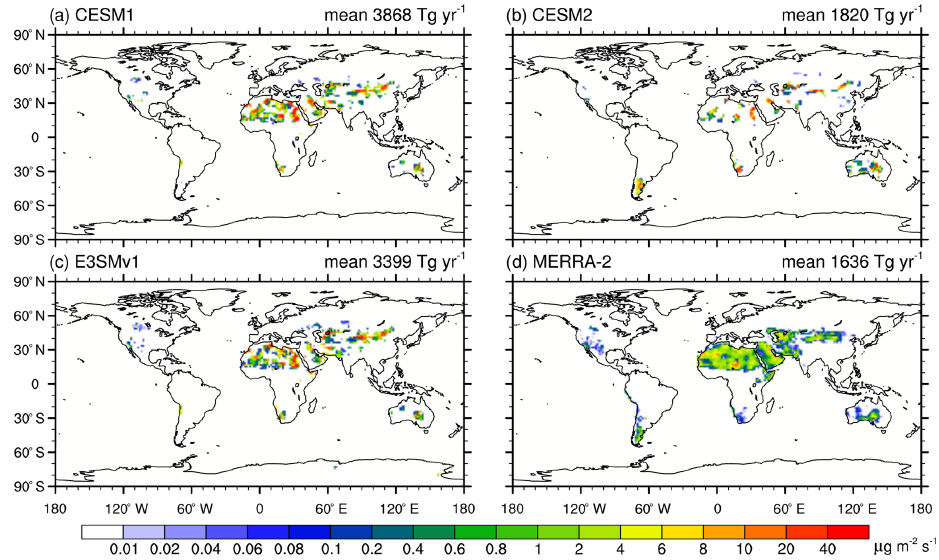
Figure 2. Spatial distributions of global annual mean dust emission (µgm − 2 s − 1 ) from model experiments. The values are global annual mean dust